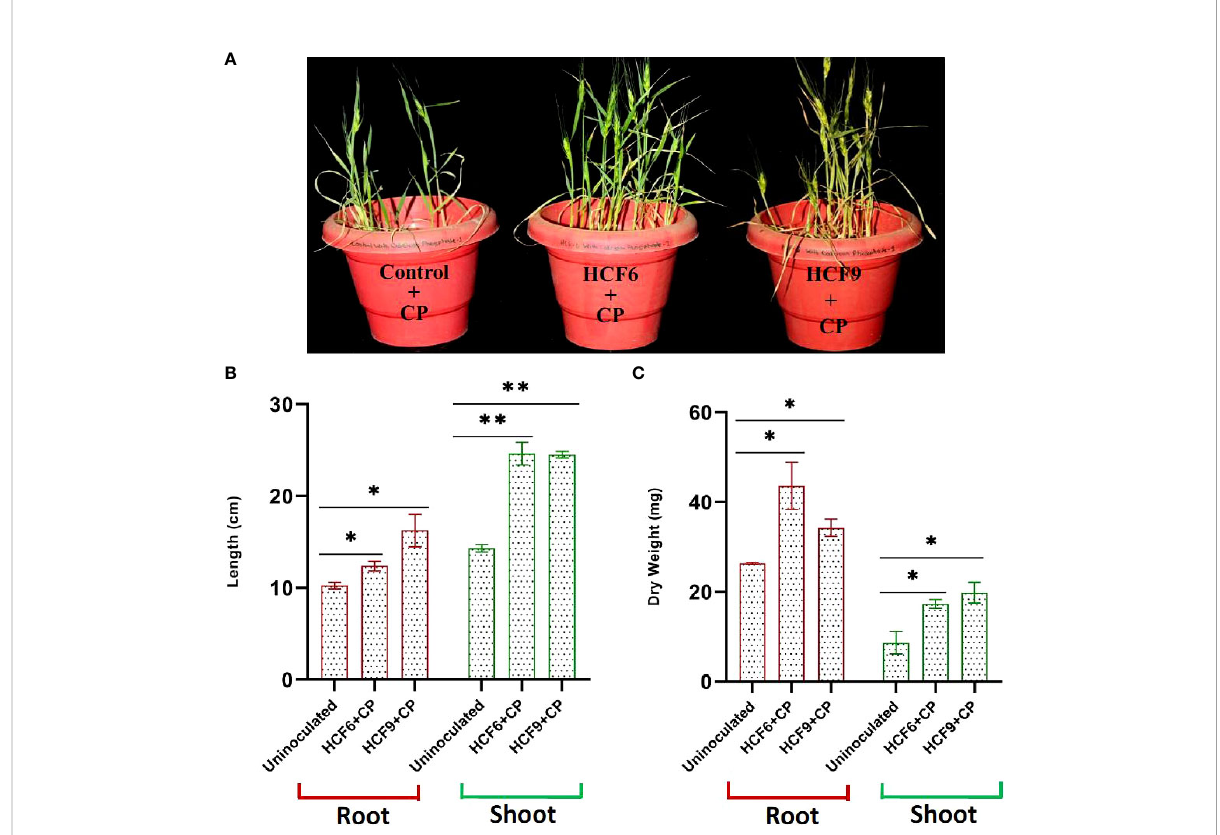
FIGURE 3 Effect of different bacterial inoculants when treated along with Ca 3 (PO 4 ) 2 (CP) on wheat plant grown in sand as growth medium. (A) Image of 45 days old wheat plant (B) Root and shoot length (cm) (C) Dry mass of root and shoot (mg). Data represent the mean values ( n= 6 ± SE) of two independent experiments. **P < 0.01; *P <